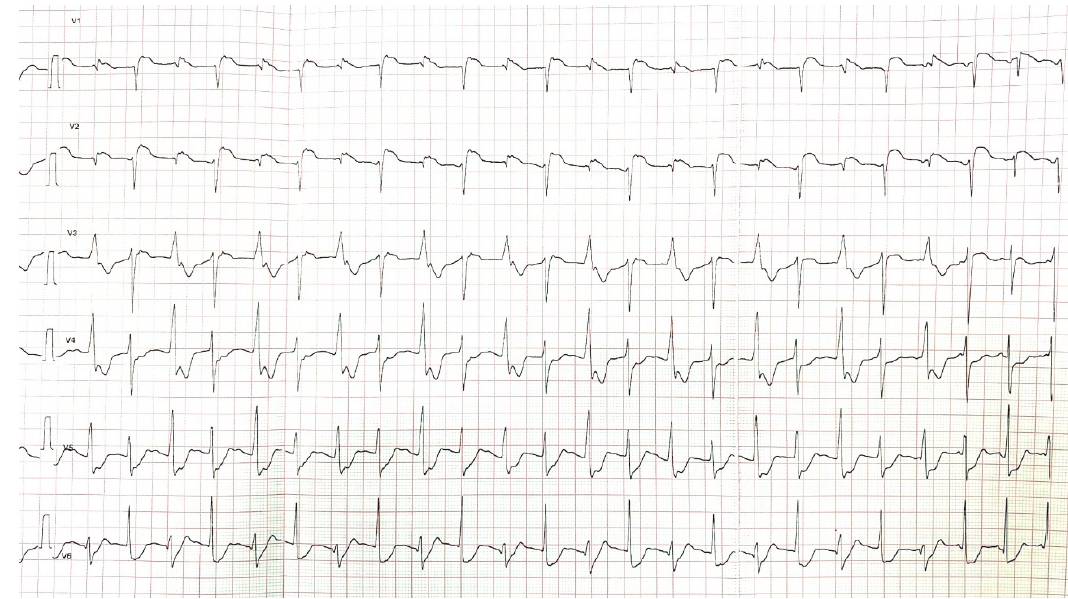
Figure 2. Bidirectional ventricular tachycardia recorded during the stress test performed by one of the probands in our case (D.M.).